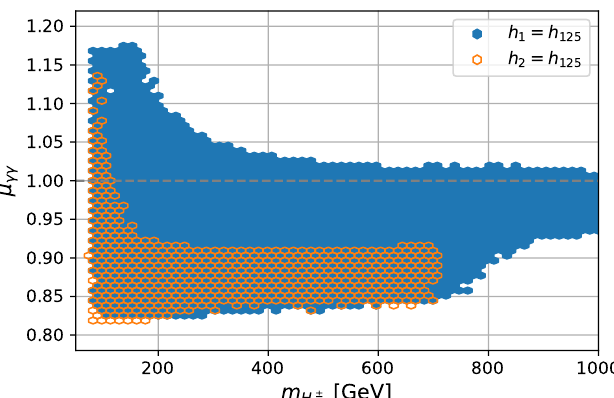
Figure 4. Scatter plot of the signal strength µ γγ of h 125 as a function of the charged Higgs mass. The dashed line indicates the SM value of µ = 1 . For the blue (orange) points the light (heavy) γγ CP -even Higgs boson is h 125 . To allow a clear distinction of these cases, parameter points where both m [120 , 130] GeV are not h 1 , m h 2 ∈